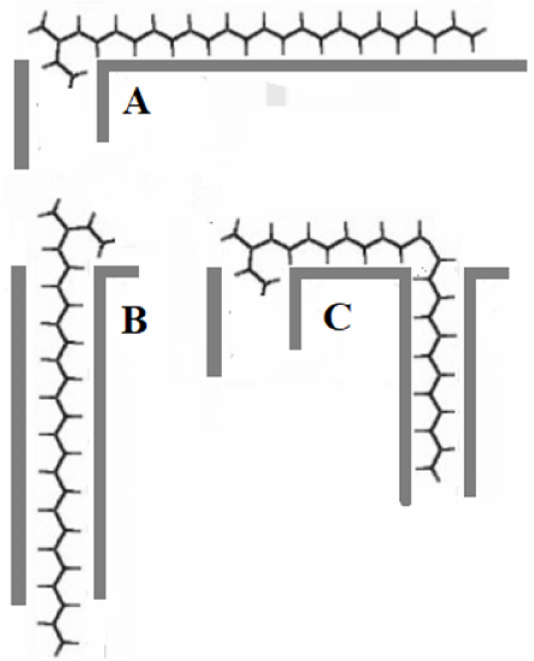
Figure 4. Possible key-lock adsorption configurations of 3-methylpentacosane. ( A) The configuration with the shortest end of the backbone, before the methyl branch, adsorbed in the pore. The longest end of the backbone is adsorbed on the surface of the material; ( B ) the configuration where the longest end of the backbone is adsorbed in the pore and the shortest end of the backbone is adsorbed on the surface of the material; ( C ) the configuration where the shortest end of the backbone is adsorbed inside a pore and the longest end of the backbone reaches the next pore opening, allowing it to be partially adsorbed inside this pore.